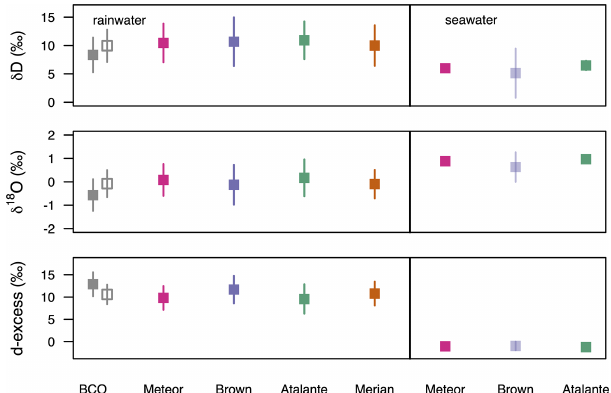
Figure 11. Campaign-mean rainwater and near-surface seawater values from the BCO and ship-based platforms. Whiskers repre- sent standard deviations. The rainwater comparison excludes Brown samples flagged for delayed collection times, the first Atalante sam- ple, and BCO and Merian samples flagged because no precipita- tion was detected by the platform’s primary meteorological sta- tion. Filled symbols for the BCO include rainwater collected every 10min during the trailing cold front on 22 January while open sym- bols do not. The seawater comparison excludes flagged Atalante samples and seawater samples taken from a depth greater than 10m. Brown seawater values are still preliminary and laboratory analysis of Brown seawater